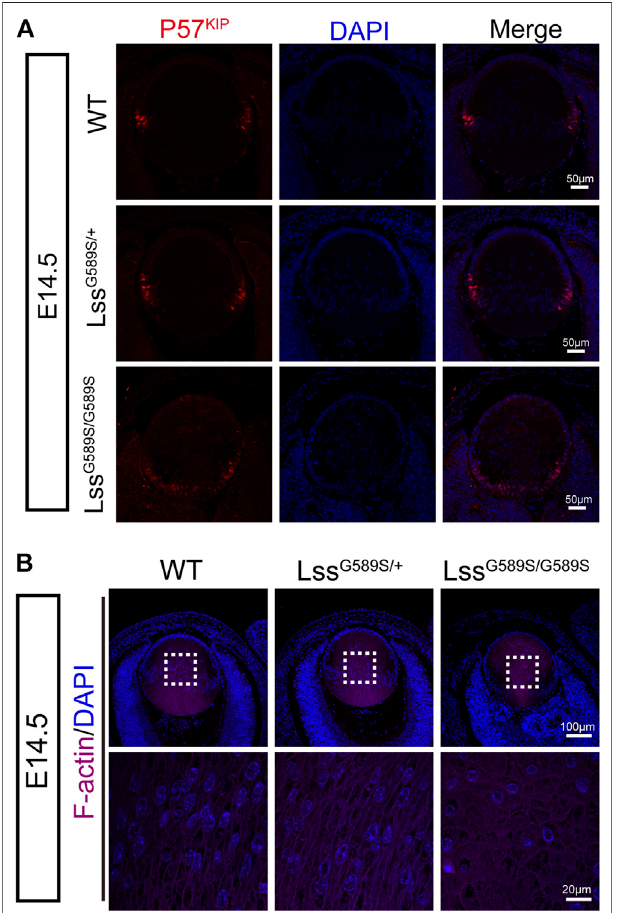
FIGURE7| Incomplete differentiationoflens fi bercellsinLss G589S/G589S mice. (A) The expression of p57 KIP2 in WT, Lss G589S/+ , and Lss G589S/G589S mice lens at E14.5. Scale bar: 50 μ m. (B) The distribution of lens fi ber nuclei and alignment of lens fi ber cells in WT, Lss G589S/+ , and Lss G589S/G589S mice at E14.5 using F-actin staining. Scale bar: 100 μ m. The enlargement is the magni fi cation of the boxed inset shown in the upper panel. Scale bar: 20 μ m.